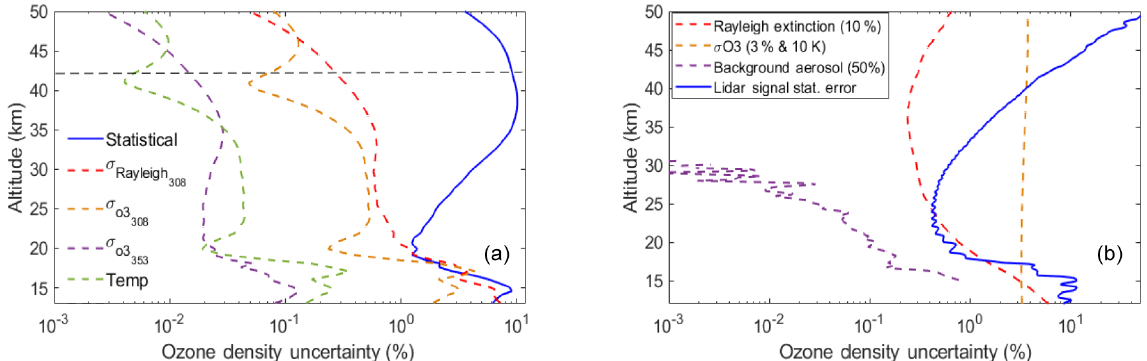
Figure 11. For the night of 26 July 2017. The statistical uncertainty of the OEM (blue), the Rayleigh-scatter cross section uncertainty at 308nm (red), the ozone absorption cross section at 308nm (orange), and the ozone absorption cross section for the 355nm channel (purple). The horizontal dashed line shows the height below which the retrieval is independent of the a priori profile.